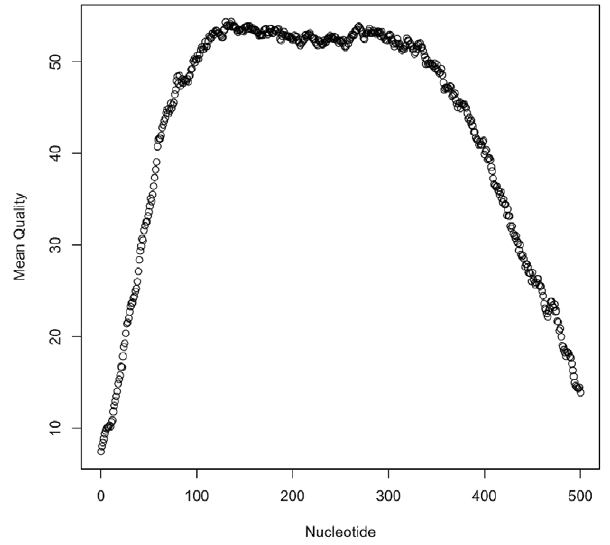
Figure 3. Average quality score over fragment length. The average quality score [10] for each position from the start of the